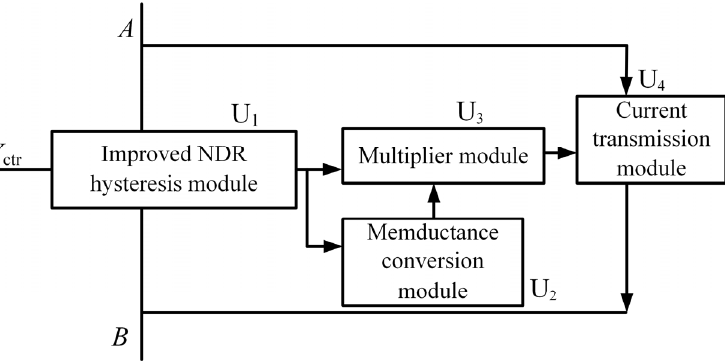
Figure 8. Diagram of threshold-controllable memristor emulator based on NDR units.